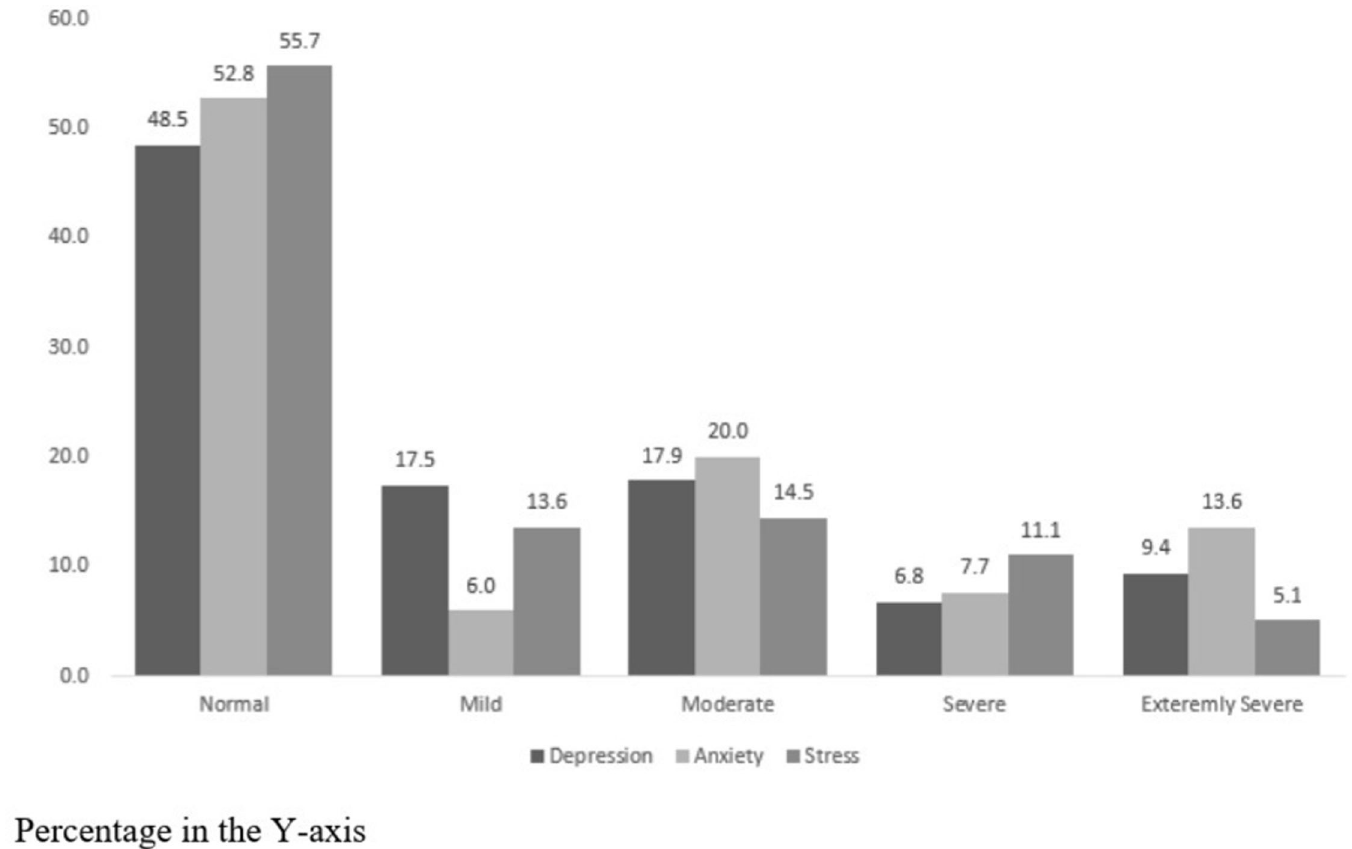
Fig 1. Frequency of symptoms and severity for depression, anxiety and stress by the DASS